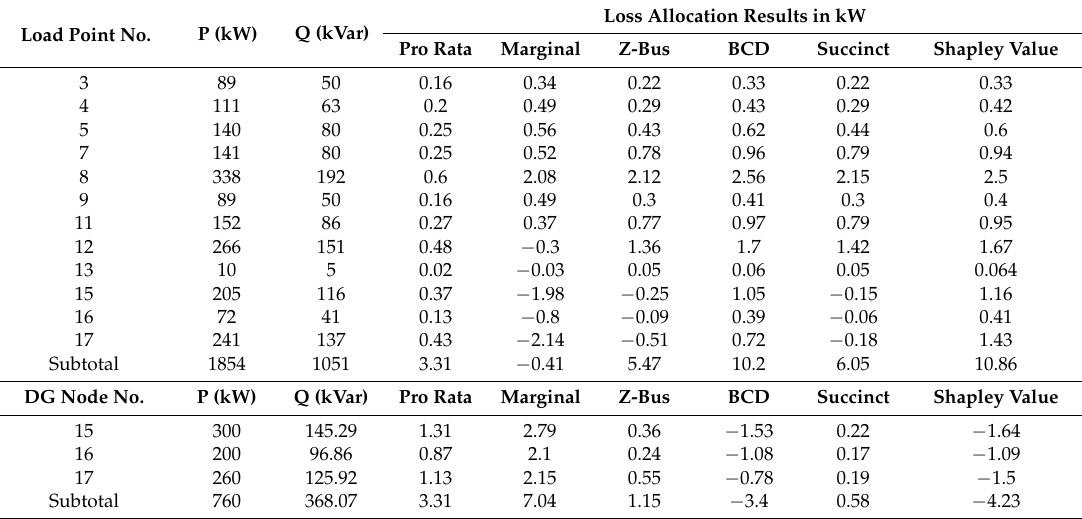
Table 2. Load and DG data with loss allocation